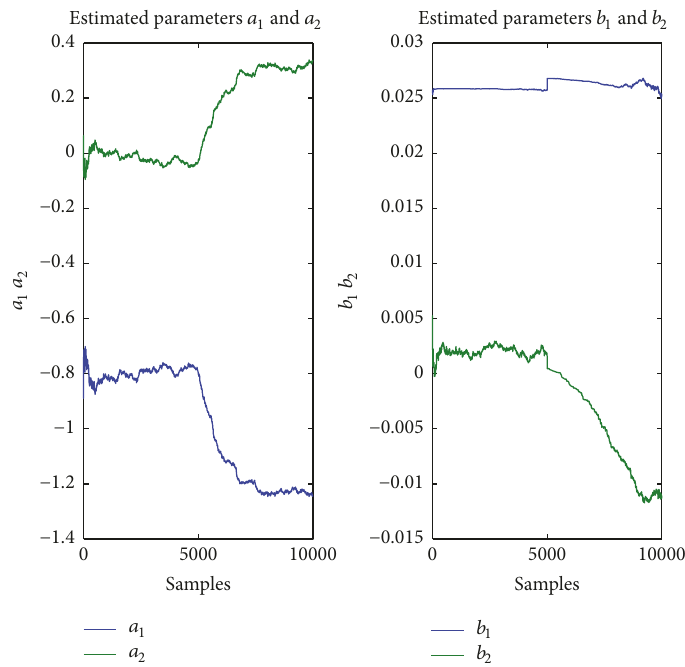
Figure 8: Refined process parameters using the LM algorithm.